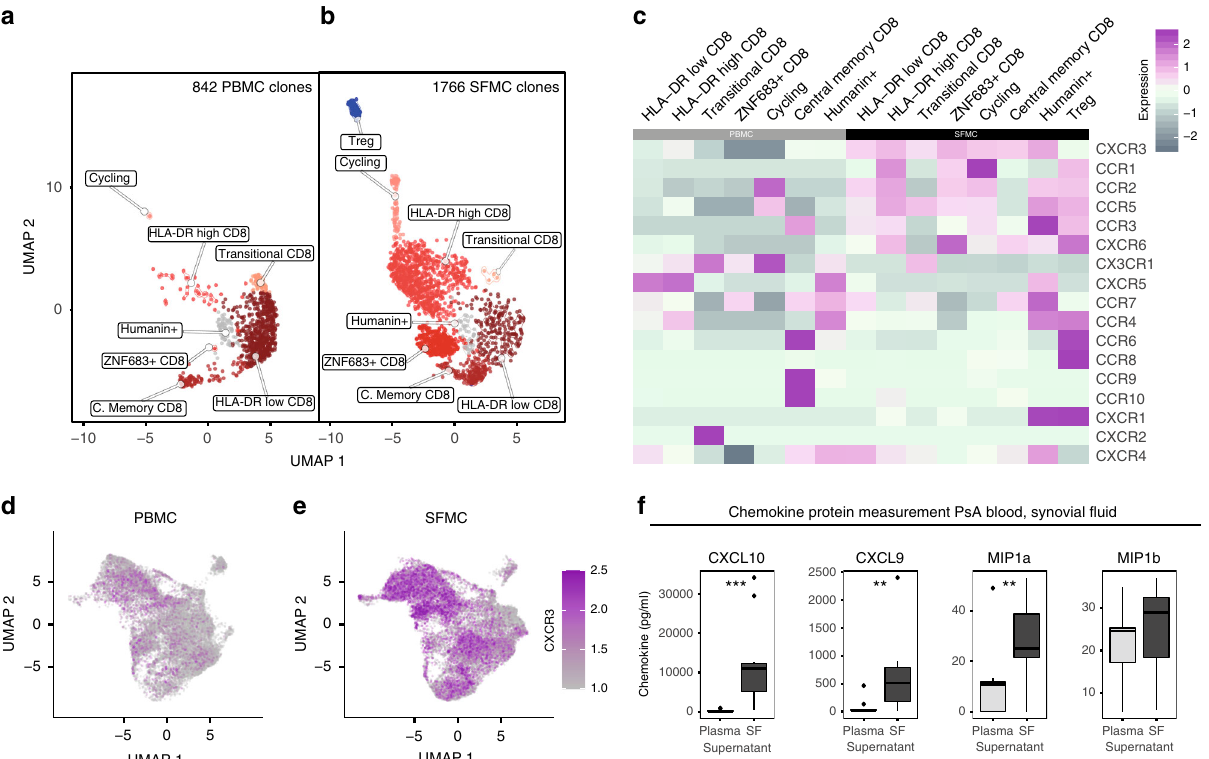
Fig. 5 Clonal T-cell traf fi cking in psoriatic arthritis. a , b UMAP of 2608 (1766 synovial, 842 peripheral blood) T cells from clones signi fi cantly enriched (adjusted p value ≦ 0.05, two-sided Fisher ’ s exact test with Benjamini – Hochberg correction for three patients) in PsA synovial fl uid and blood, respectively, split by tissue of origin. Peripheral blood cells in panel a , synovial fl uid cells in panel b . c Heatmap of signi fi cantly expanded blood and synovial T-cell clone clusters (columns) split by tissue of origin and showing chemokine receptor expression (rows). From paired blood and synovial fl uid of three patients. d UMAP of 5 ′ 10× data set T cells derived from PBMC of three patients with CXCR3 expression highlighted. e UMAP of 5 ′ 10× data set T cells derived from SFMC of three patients with CXCR3 expression highlighted. f CXCL10, CXCL9, MIP1 α and MIP1 β protein quanti fi cation by LegendPlex in paired plasma and synovial fl uid supernatant from 11 independent PsA patients, all replication attempts were successful. For all boxplots, the upper whisker extends to the largest value, maximally 1.5× IQR from the 75th centile, and the lower whisker extends to the smallest value, 1.5× IQR from the 25th centile. The junctions of whisker and box (hinge) represent the 25th and 75th centiles, while median is indicated by the central line. Outlier values are plotted individually beyond the whiskers. Two-sided paired t test with Bonferroni correction (** = p < 0.01, *** = p < 0.001). Exact p values CXCL10 = 8.5 − 5 , CXCL9 = 0.0052 and MIP1a = 0.0055). Source data are provided as a Source Data fi